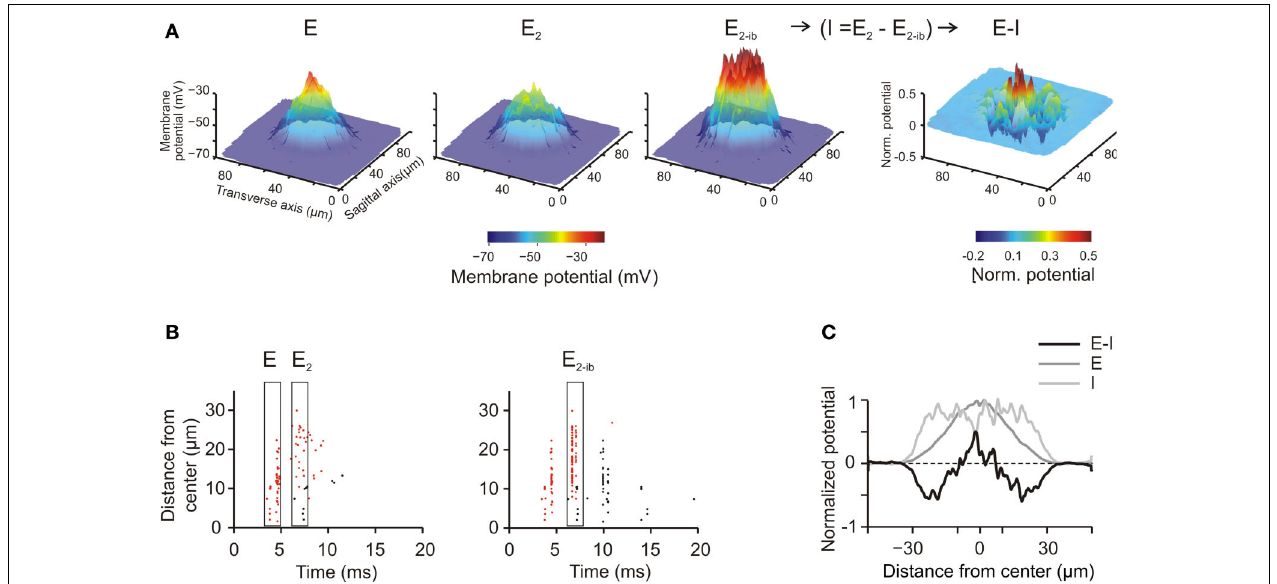
active GrCs ordered from center to periphery [data from one of the simulation used to make (A) ]. The fi rst spikes are indicated by red dots, the second and following spikes by black dots. In the center the fi rst spike occurs about 5 ms ). 2 after the stimulus, whereas in the surround it tends to occur later. The second spike, which is quite rare in control, becomes well evident when inhibition is blocked. (C) The spatial profi le of inhibition (I) was subtracted from the profi le of excitation (E) to obtain the E-I balance (E-I) along a section passing through the core of the corresponding plot in (A) (average data obtained from 10 simulations with different random seeds for synaptic connectivity). The larger extension of inhibition compared to excitation and the Mexican-hat profi le of the E-I balance are